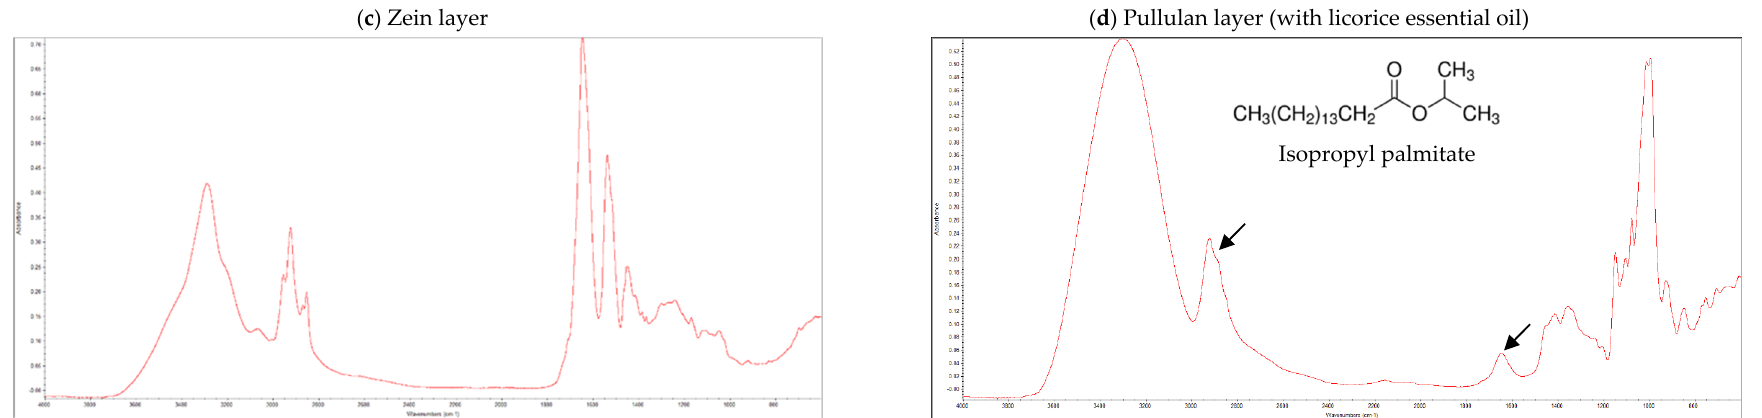
Figure 1. Fourier-Transform Infrared Spectroscopy (FTIR) spectra of the bilayer control film ( a ) zein layer, ( b ) pullulan layer; and bilayer film with licorice essential oil ( c ) zein layer, ( d ) pullulan layer.3.2. Microstructure of Bilayer Films.